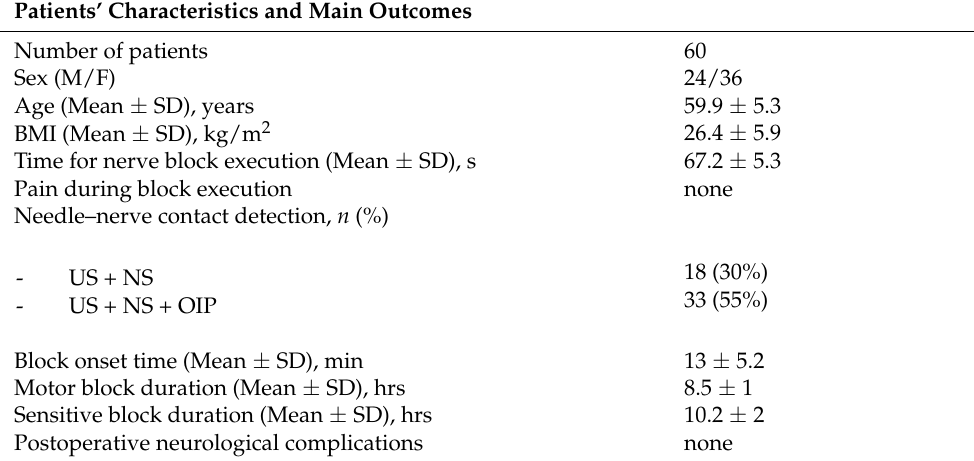
Table 1. Patients’ characteristics and main outcomes.